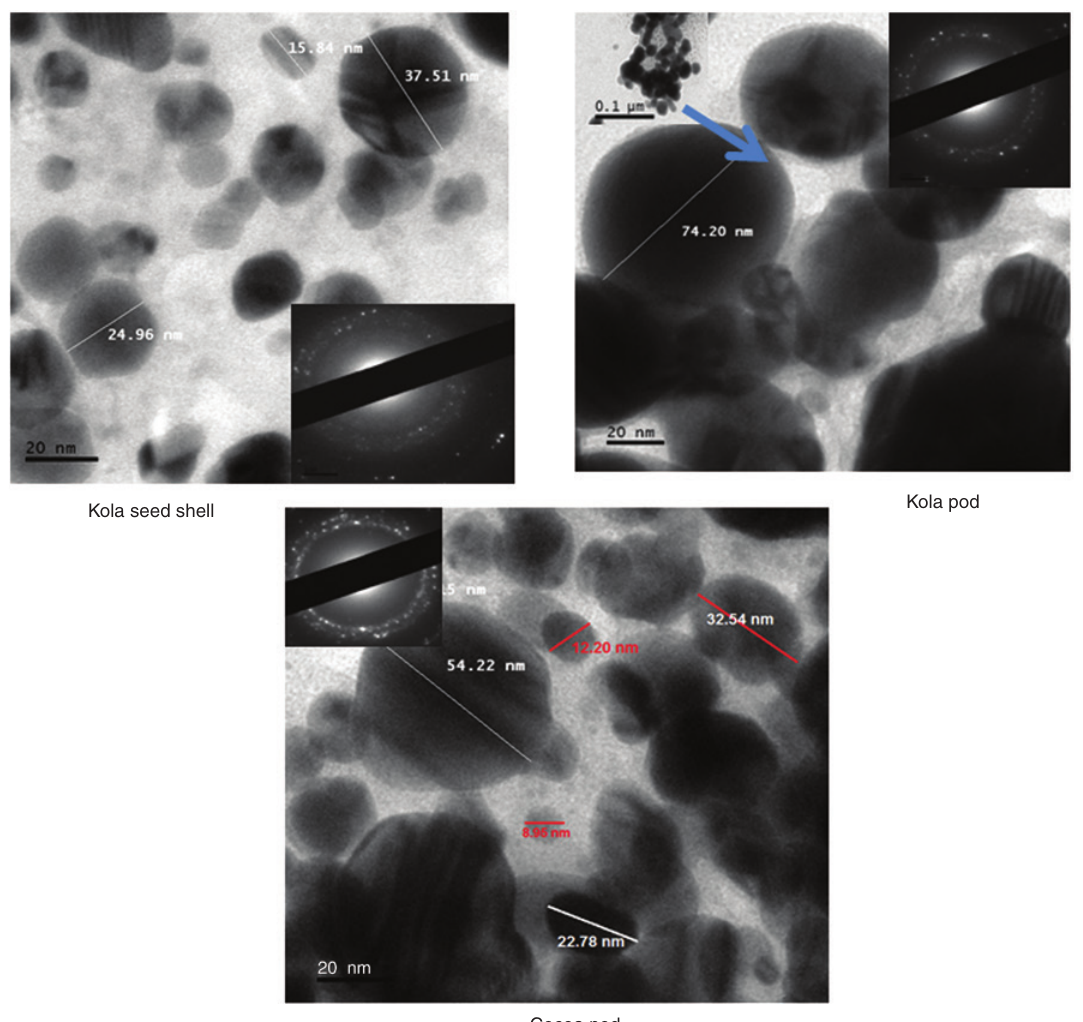
Figure 5: TEM images of biosynthesized AgNPs using some important agro-wastes (inset, SAED pattern).